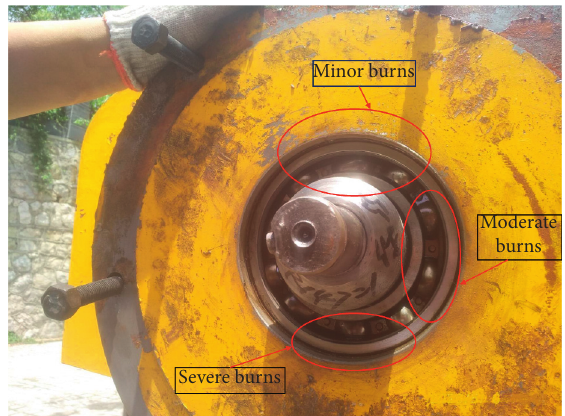
Figure 13: Bearing burn fault.